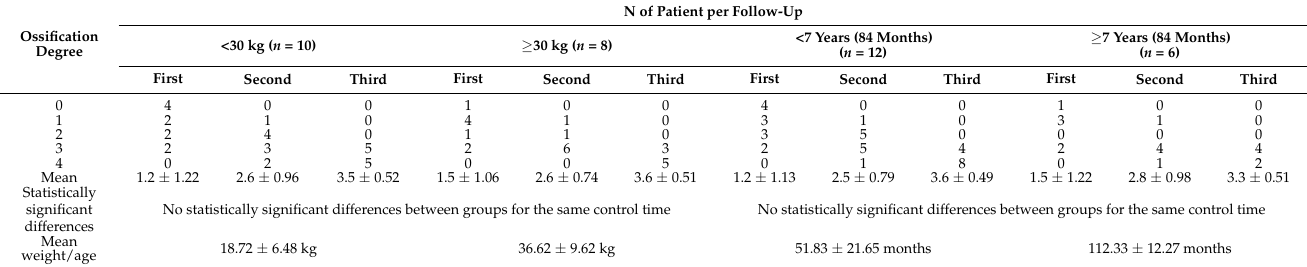
Table 3. Number of patients distributed by ossification degree in the different follow-ups divided by body weight and age. Ossification Degree